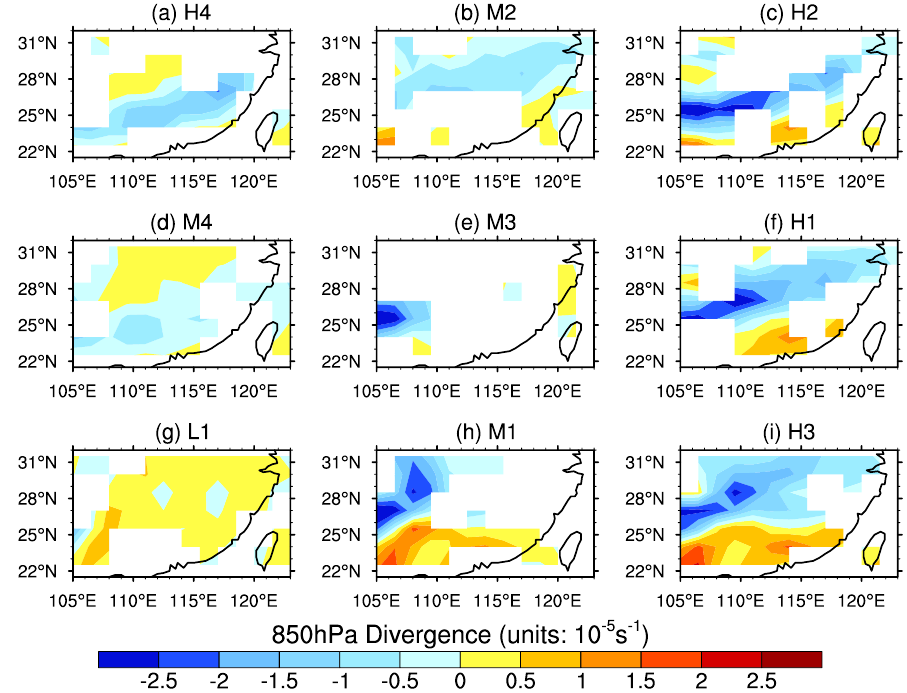
Figure 5. ( a – i ) Composite means of divergence (units: 10 − 5 s − 1 ) at 850hPa for the nine regimes during AMJ 1979–2015. Only composite means that pass the 95% confidence level based on two-sided Student’s t test against the complementary set of samples are plotted.